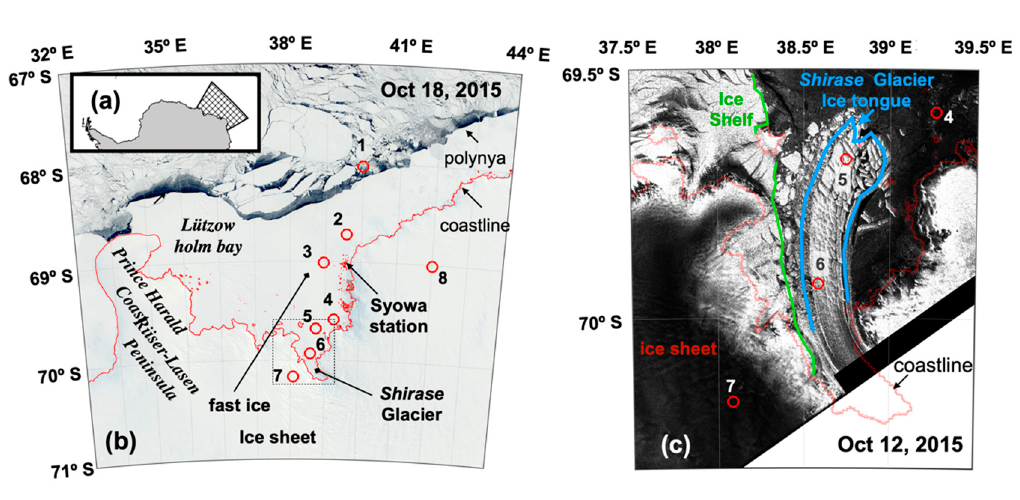
Figure 1. Ice conditions in Lüzow-Holm Bay, East Antarctica, and surrounding areas: ( a ) Map of eastern Antarctica and ( b ) an overall view of Lützow-Holm Bay from an Aqua Moderate Resolution Imaging Spectroradiometer (MODIS) image acquired on 18 October 2015. ( c ) An enlarged view around the Shirase glacier tongue provided by a Sentinel-1 C-band synesthetic aperture radar (C-SAR) image acquired on 12 October 2015. The reference points intended to represent the five types of ice identified in the MODIS images, which include the following: (1) Drift ice, (2) multi-year fast ice including grounded icebergs, (3) first year fast ice, (4) multi-year fast ice, (5) tip of the Shirase Glacier tongue, (6) main part of the Shirase Glacier tongue, (7) a coastal ice sheet, and (8) an inland ice sheet.